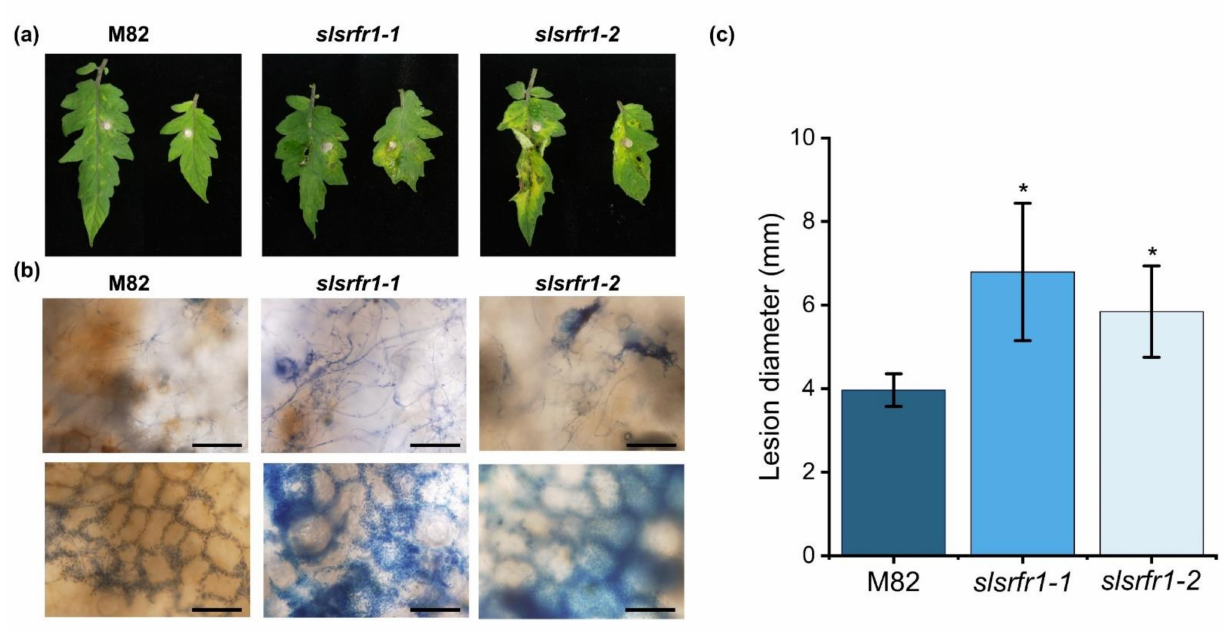
Figure 8. Plant response to Fusarium oxysporum f. sp. lycopersici in slsrfr1 lines. Plant response was analyzed at 3 days after plug inoculation of FOL in slsrfr1 lines. ( a ) Detached leaves from 6-week-old M82, slsrfr1-1, and slsrfr1-2 were inoculated with 4 mm-diameter plugs of F. oxysproum . Photographs were taken at 3 DPI; ( b ) Trypan blue staining in FOL -inoculated slsrfr1 lines. The bar represents 200 µ m in the upper layer and 100 µ m in the lower layer; ( c ) lesion size at 3 DPI in slsrfr1 lines. Plant response of slsrfr1-1 and slsrfr1-2 against FOL was repeated three times and once, respectively, with similar results. A statistically significant difference was determined by the Student’s t -test (* p < 0.01